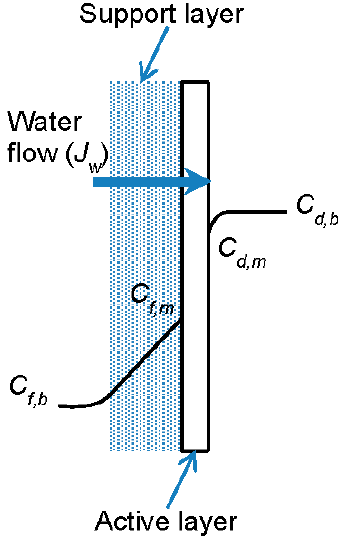
Figure 3. A diagram representing the concentration polarization for an asymmetric membrane with the support layer due to the water flow through the membrane. Here C f,m and C d,m are concentrations of salt on the feed and draw sides of the active layer respectively and C f,b and C d,b are the bulk concentrations on the feed and draw sides of the membrane respectively.